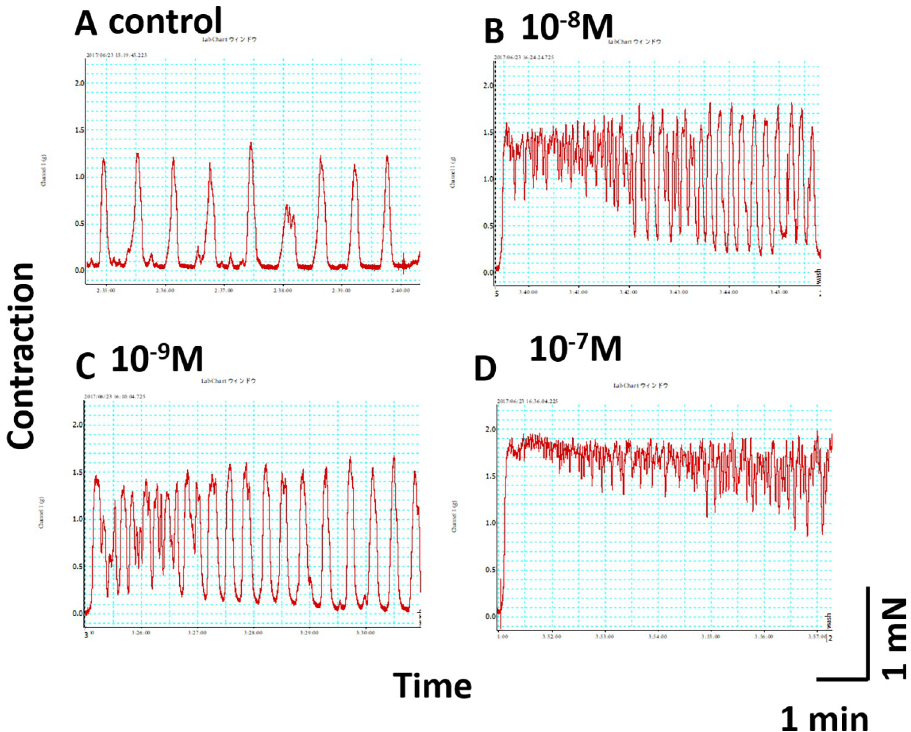
Fig 4. Representative ex vivo contractility traces of myometrial strips isolated from virgin mice. After spontaneous rhythmic uterine contraction, ( A ) effects of indicated concentrations of FBOT, ranging from 1 nM to 100 nM ( B-D ) were examined in the same muscle strip. Contractions were recorded for 6 min. The time interval between drug application and washing was 30 min.